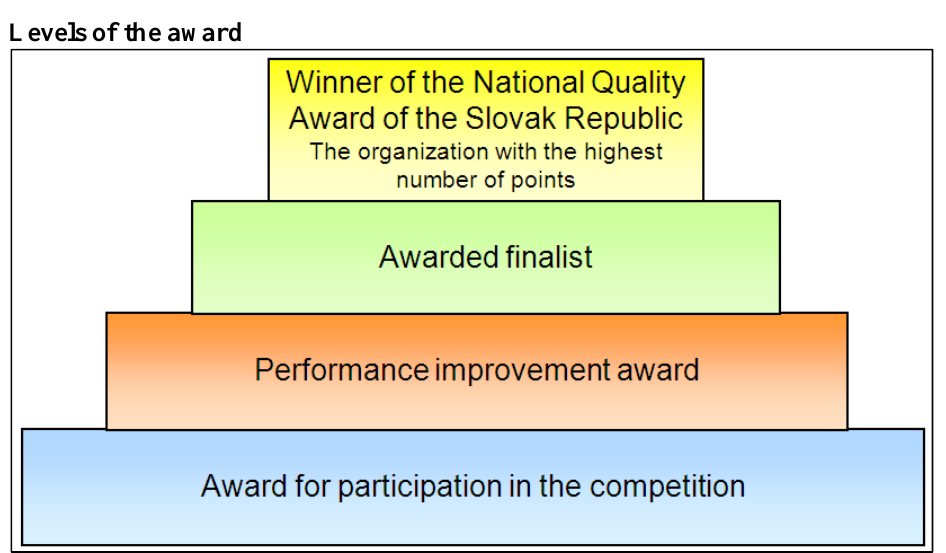
Fig. 1 Levels of the National Quality Award of the Slovak